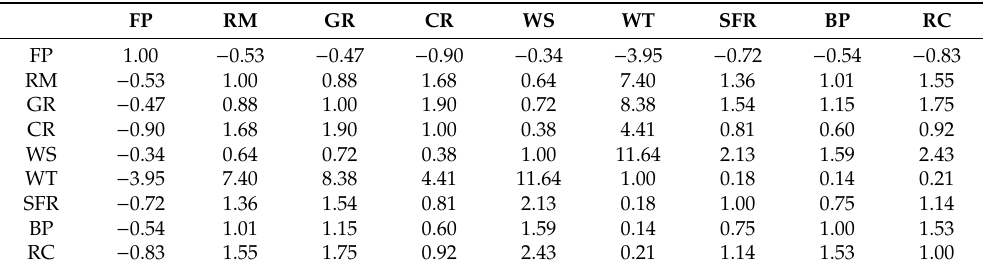
Table 8. Ecosystem services trade-o ff degrees in Jiangxi province from 1995 to 2015.